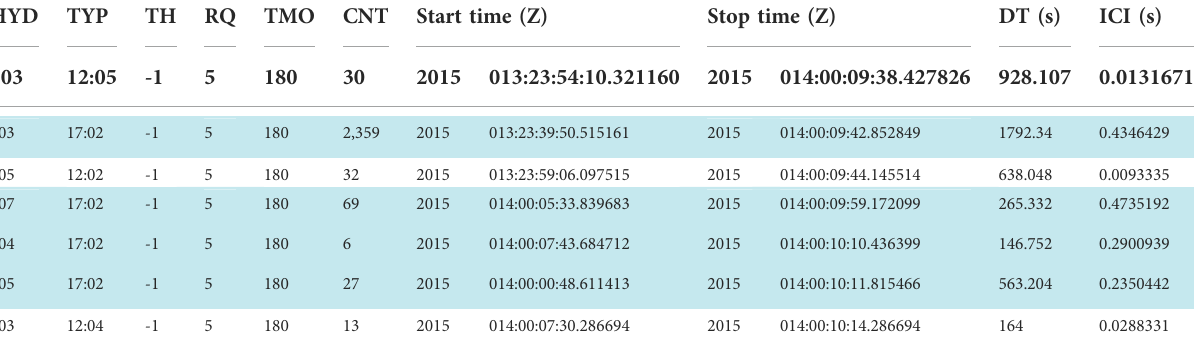
TABLE 2 Un fi ltered CTP output from SOAR from January 2015 with CS-SVM Zc click trains (TYP 17:02) highlighted in blue. The columns from left to right are hydrophone number (HYD), algorithm type and class (TYP), minimum click threshold (TH, unused here), required number of detections to save a click train (RQ), number of seconds without detection that causes click train to close (TMO), number of clicks in the train (CNT), Start and Stop (Year, Day:HH:MM:SS.S), duration of train (DT), estimated interclick interval